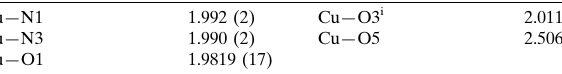
Key indicators: single-crystal X-ray study; T = 295 K; mean (cid:1) (C–C) = 0.004 A˚; disorder in solvent or counterion; R factor = 0.036; wR factor = 0.098; data-to- parameter ratio = 14.2.